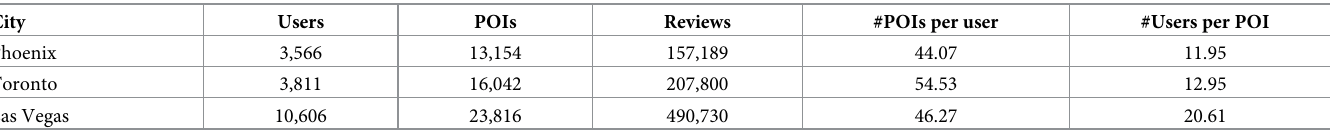
Table 1. Statistics from the Yelp data set for three cities. City